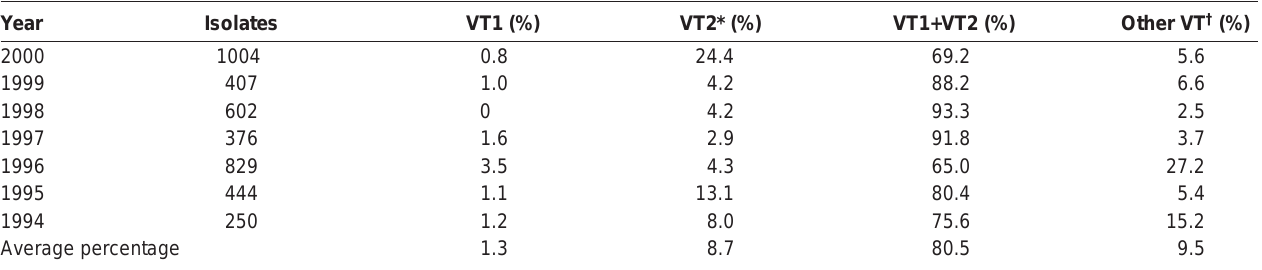
TABLE 6 Verotoxigenic (VT) genotypes of Escherichia coli O157:H7 identified by polymerase chain reaction, 1994 to